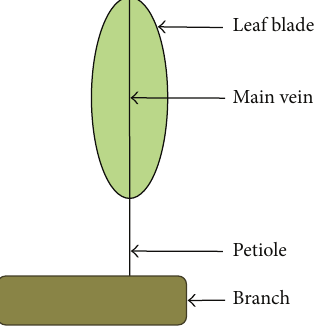
Figure 2: Leaf with petiole connected to a